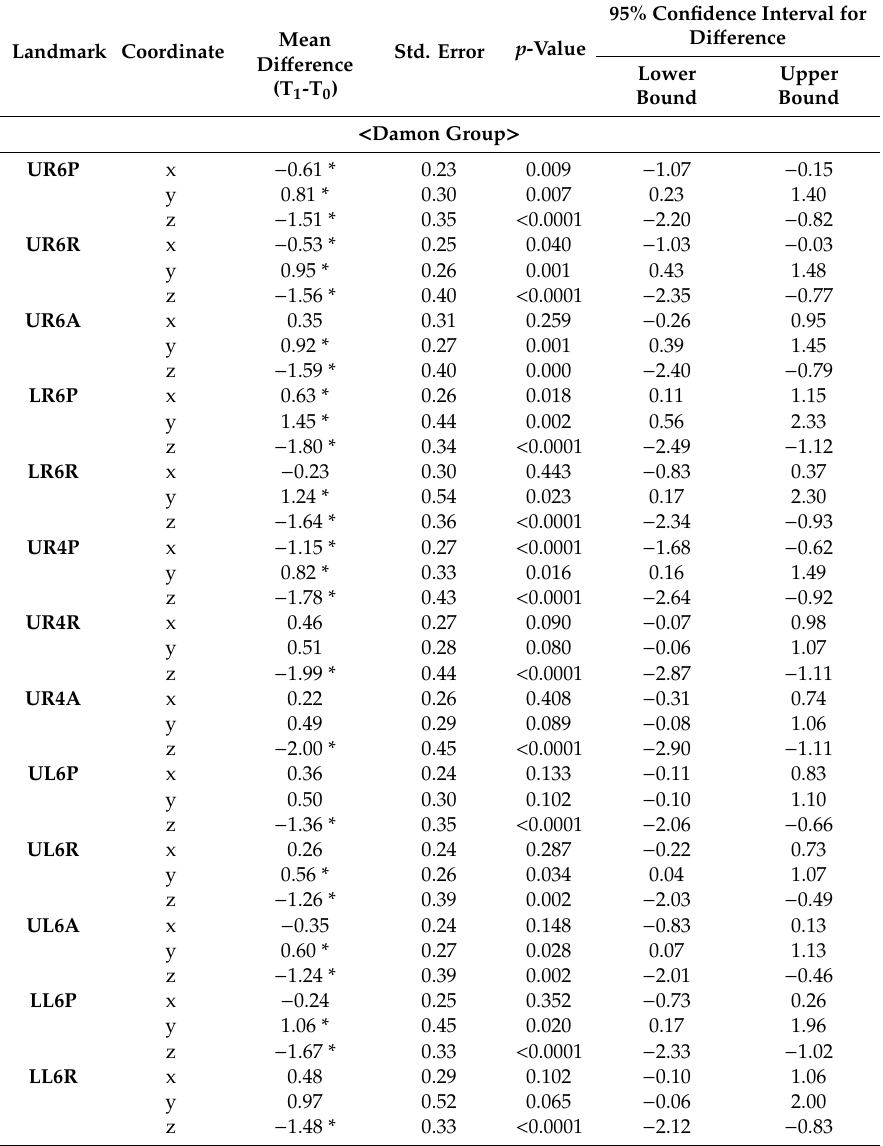
Table A1. Within group pairwise comparisons (T 1 -T 0 ) (x = transverse, y = anteroposterior, z = vertical